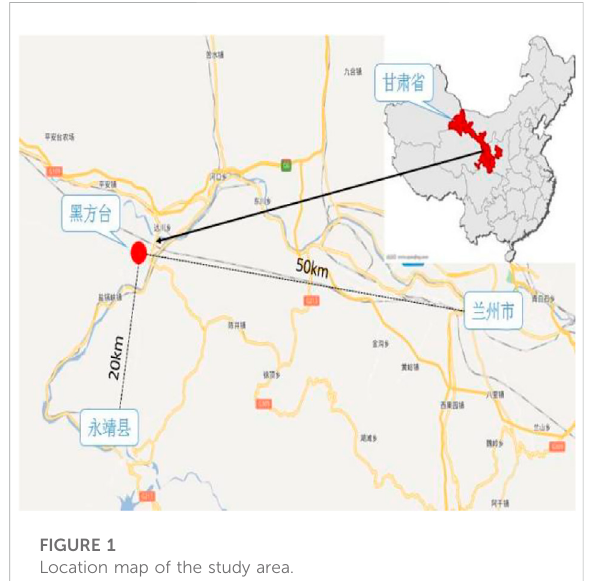
FIGURE 1 Location map of the study